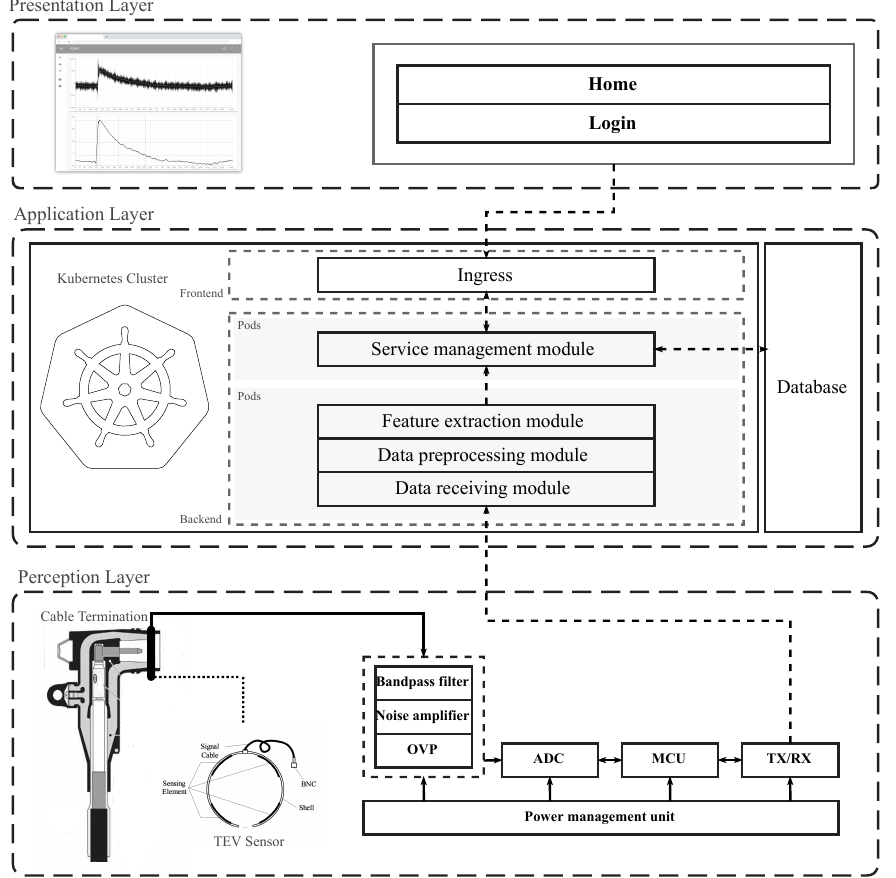
Figure 12. Overall design architecture of the OLPD monitoring system based on the TEV